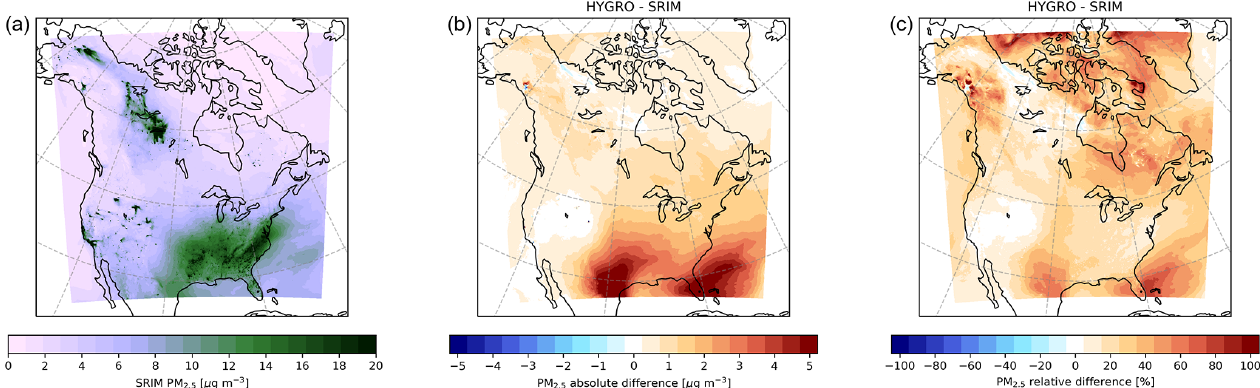
Figure 1. (a) Mean PM 2 . 5 concentrations from the SRIM simulation, (b) mean difference in PM 2 . 5 concentrations between the HYGRO and SRIM simulations, and (c) relative difference in mean PM 2 . 5 concentrations between the HYGRO and SRIM simulations.